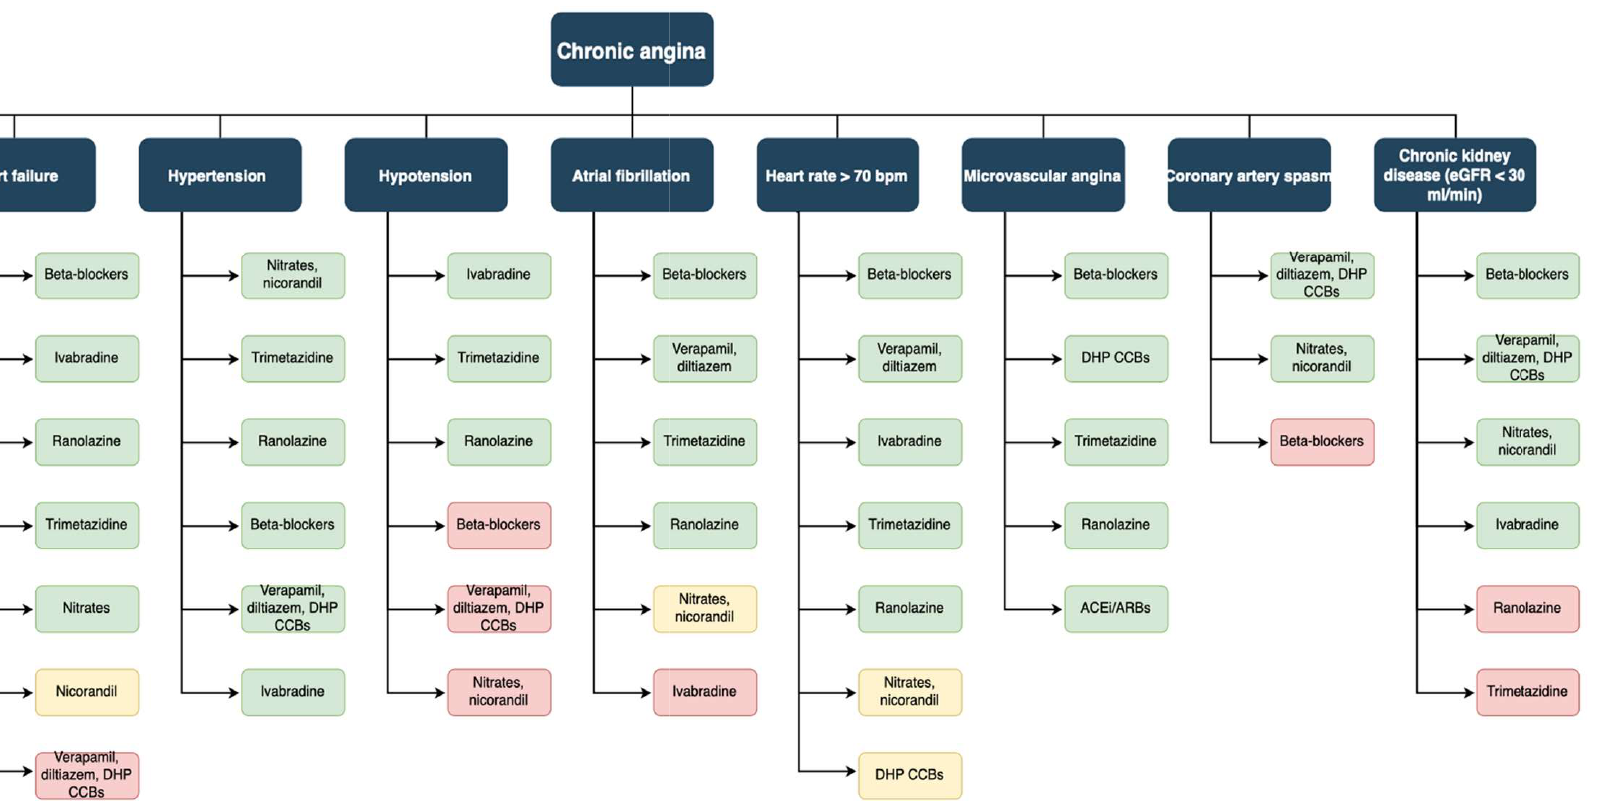
ss . Figure 2. Management of chronic angina in different clinical settings. Adapted from Ferrari et al. [86]. Green boxes: recommendable or usable drugs. Yellow boxes: